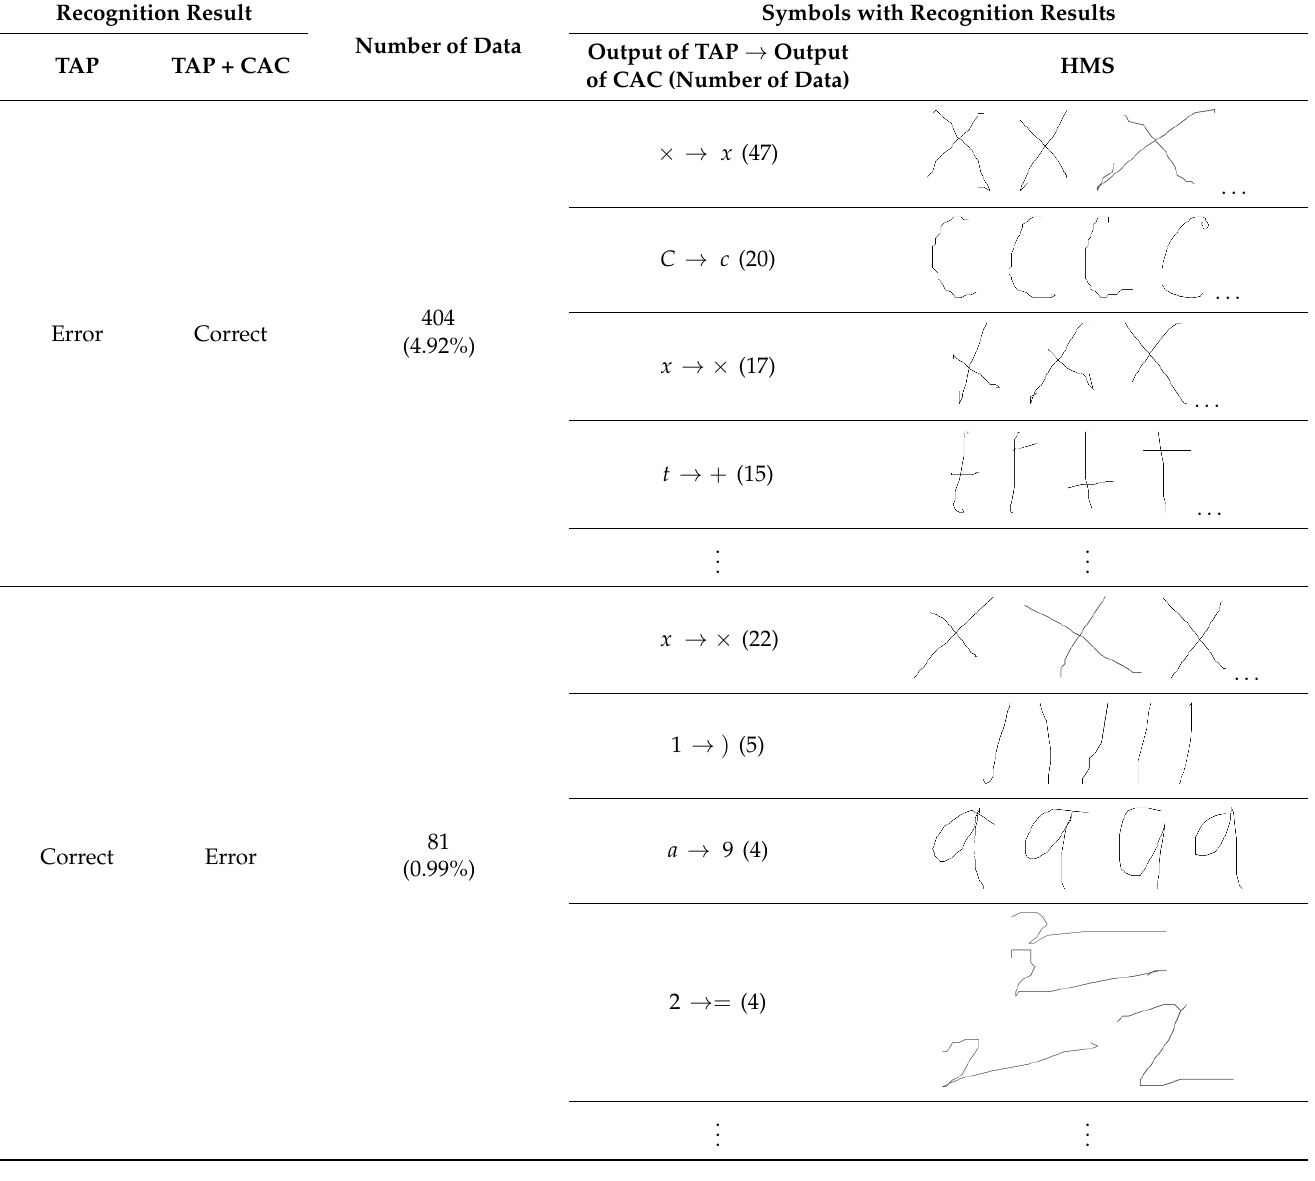
Table 11. Corrected and missed symbols using the CAC model .